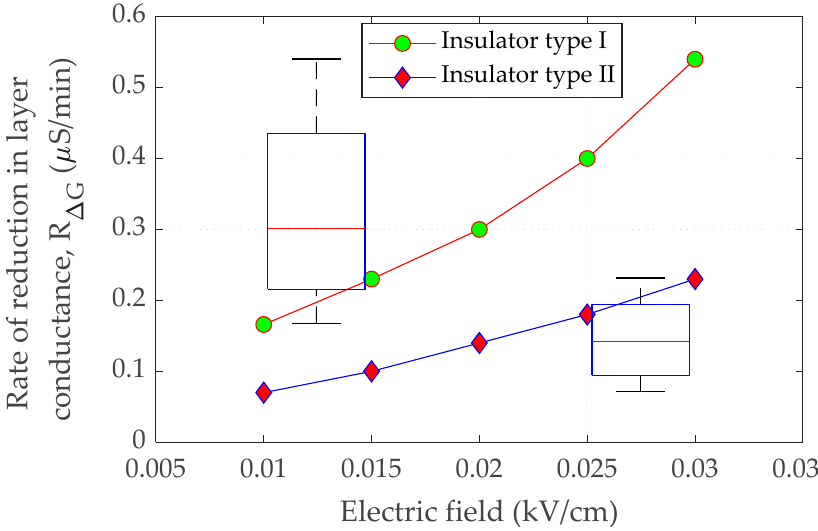
Figure 7. Rate of reduction in conductance for insulator type I and insulator type II as a function of the electric field.